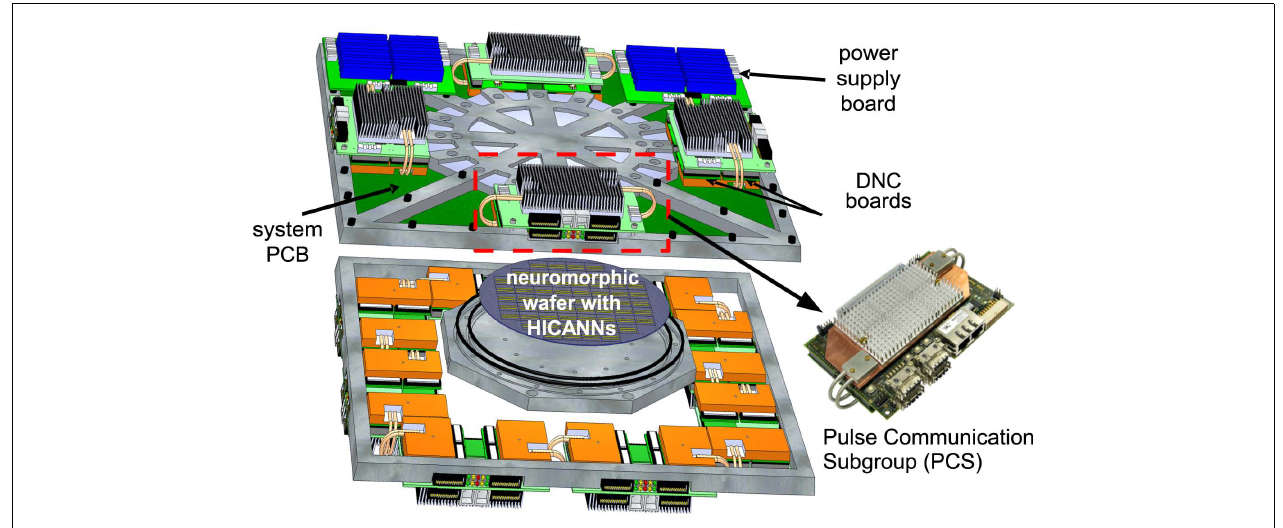
FIGURE 1 | Overview of one wafer module of the FACETS/BrainScaleS waferscale neuromorphic system (Schemmel et al., 2010).